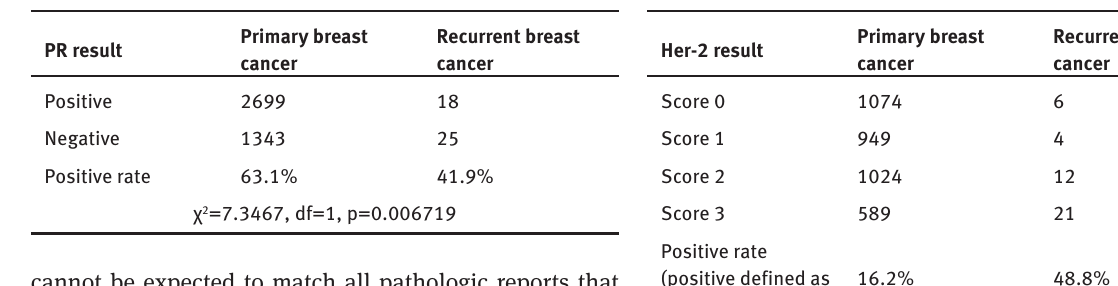
Table 4: Difference in Her-2 expression between primary and recur- rent breast